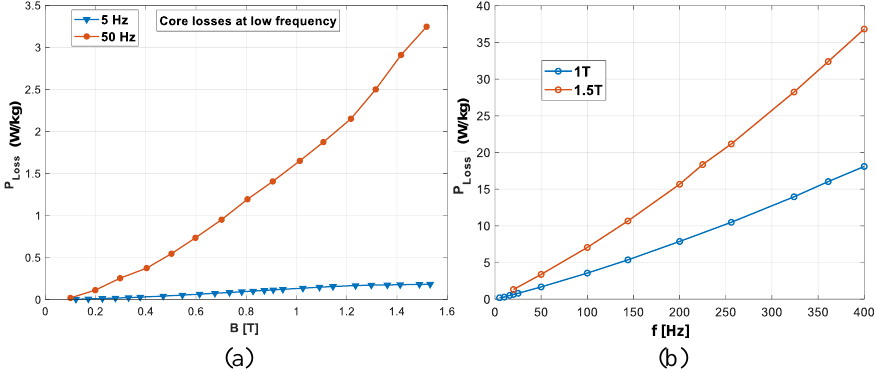
Figure 3. Experimental setup for individual laminations of the SRM at low power and low fre- quency.